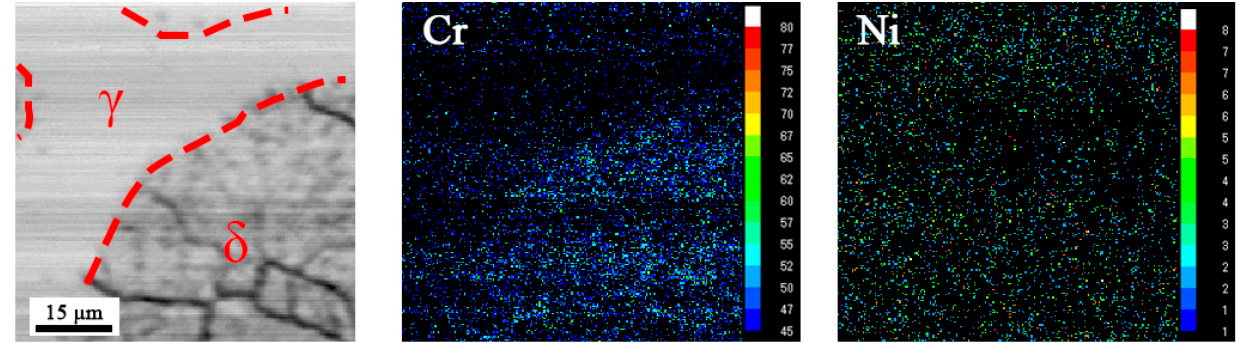
Figure 8. EPMA analysis of the as-remelted-3 kW sample.